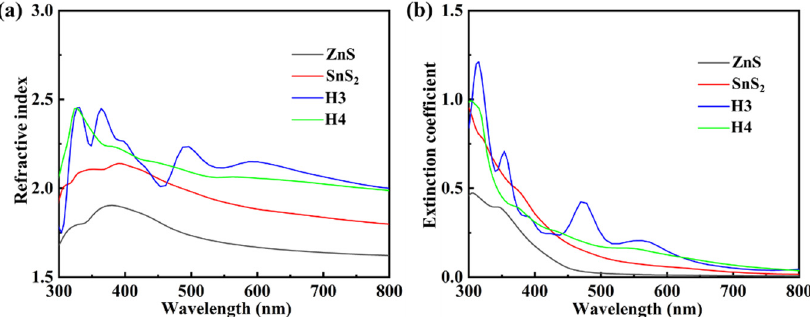
Figure 8. Refractive index ( a ) and extinction coefficient ( b ) for ZnS monolayer, SnS 2 monolayer, and H3 and H4 heterojunctions. H3 and H4